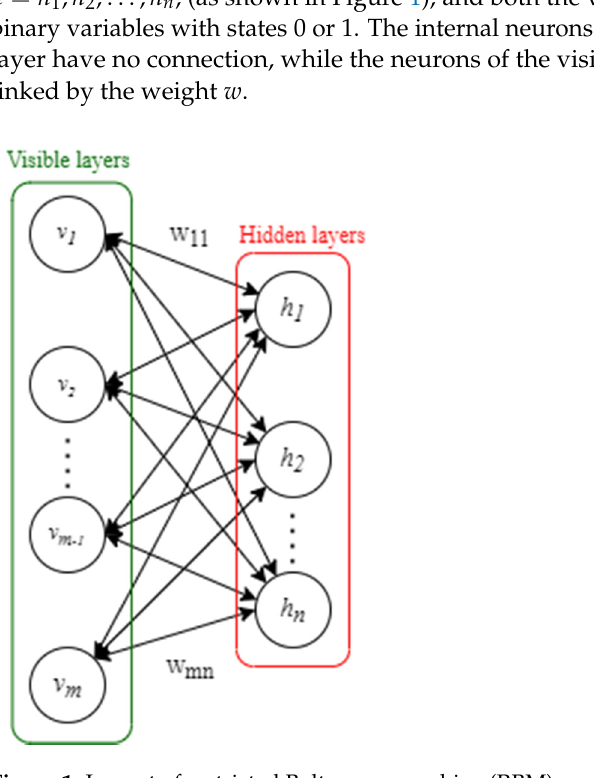
Figure 1. Layout of restricted Boltzmann machine (RBM).